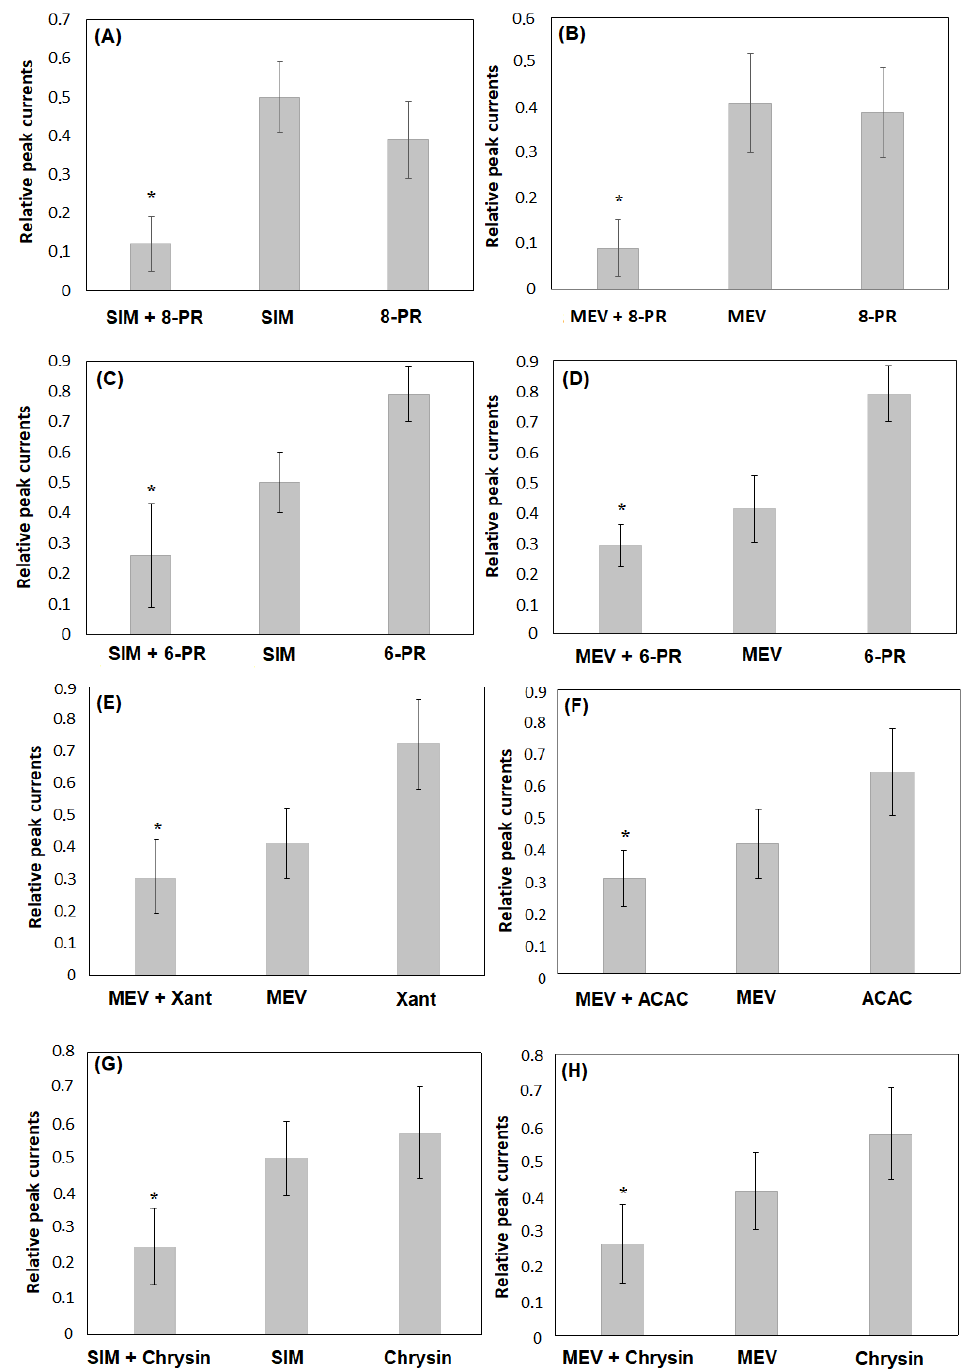
Figure 2. Relative peak currents upon co-application of ( A ) simvastatin (SIM) with 8-prenylnaringenin (8-PR), ( B ) mevastatin (MEV) with 8-PR, ( C ) SIM with xanthohumol (Xant), ( D ) MEV and acacetin (ACAC), ( E ) MEV with Xant, ( F ) MEV with ACAC, ( G ) SIM and chrysin, ( H ) MEV with chrysin, and application of each compound alone; * p < 0.05.